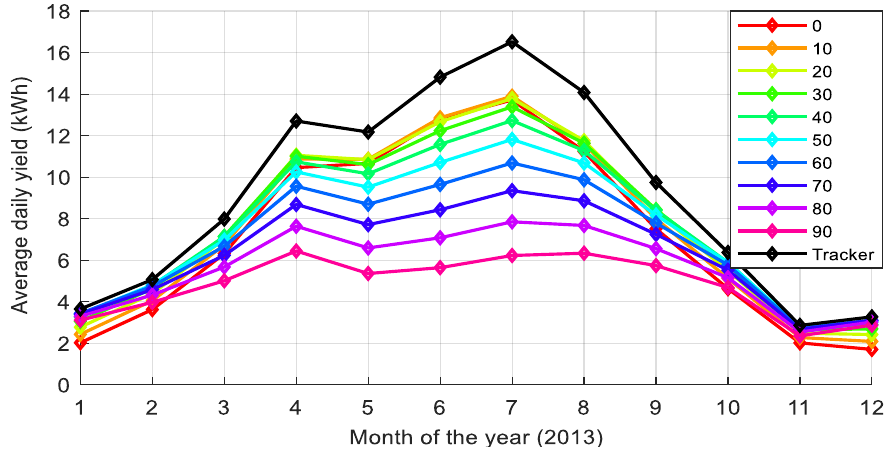
Figure 4. Average daily yield of the south facing 2.6 kW PV system for each month considering various fixed tilt angles compared to the use of a 2-axis tracker.